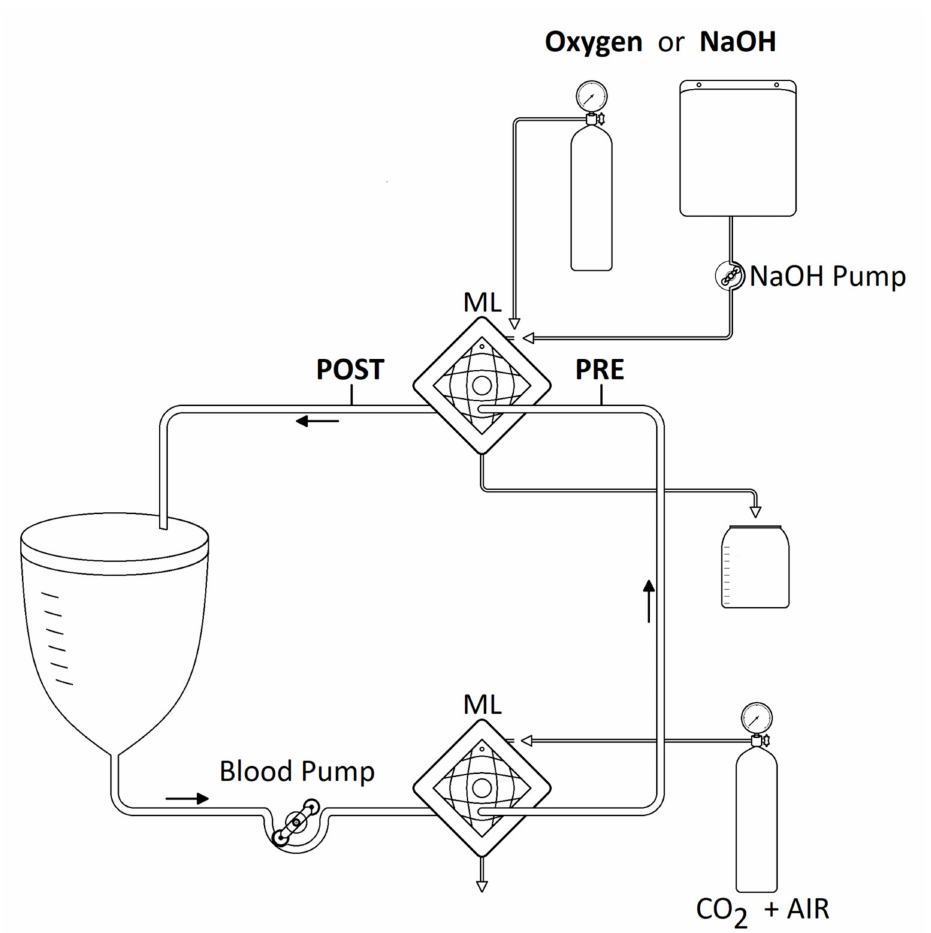
Figure 1. Schematic representation of the extracorporeal circuit. ML: membrane lung; PRE: blood sampling access upstream the ML for ECCO 2 R; POST: blood sampling access downstream the ML for ECCO 2